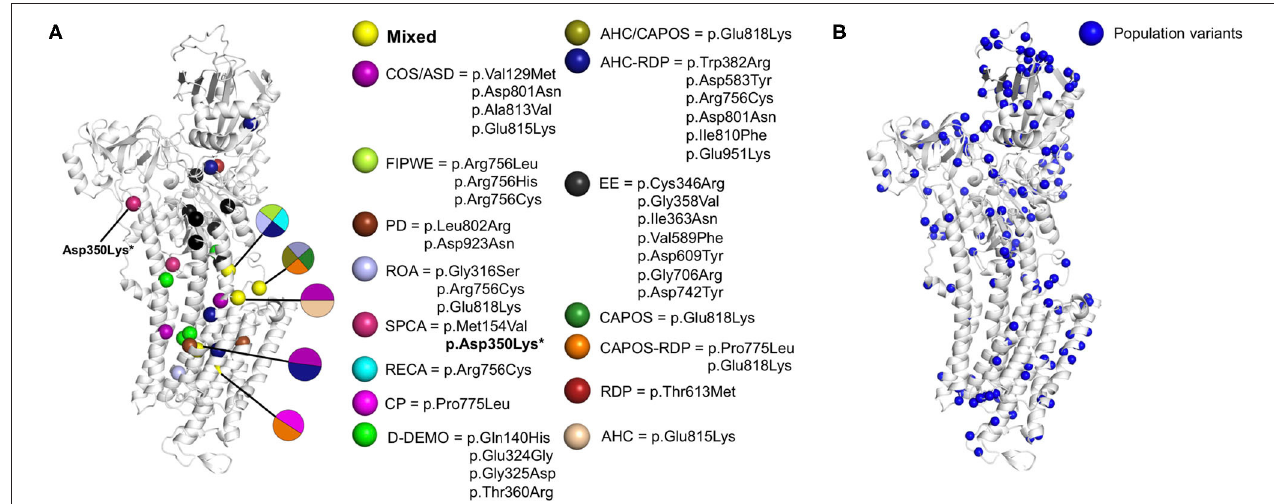
FIGURE 2 | ATP1A3 missense variants mapped on a protein structure model of the α 3 subunit of the Na + /K + -ATPase. The homology model was obtained from the SWISS-Model repository (template: 4RET). (A) Pathogenic missense variants. Spheres are colored by disorder type. Residues associated with multiple distinct disorders were colored in yellow. (B) Population variants in ATP1A3 were collected from the gnomAD database (81) and visualized as blue spheres on the homology model. *Asp350Lys did not match any protein isoform in Uniprot (82), could not be aligned to the canonical ATP1A3 sequence and is thus not displayed in the figure. In case of AHC and RDP, we only included the pathogenic variants reported as more frequent according to the references (8, 14), respectively. AHC, alternating hemiplegia of childhood; ASD, autistic spectrum disorder; CAPOS, cerebellar ataxia, areflexia, pes cavus, optic atrophy, and sensorineural hearing loss; COS, childhood-onset schizophrenia; CP, cerebral palsy; D-DEMO dystonia, dysmorphism, encephalopathy, MRI abnormalities, and no hemiplegia; EE, early life epilepsy; FIPWE, fever-induced paroxysmal weakness and encephalopathy; PD, paroxysmal dyskinesias; RECA, relapsing encephalopathy with cerebellar ataxia; RDP, rapid-onset dystonia-parkinsonism; ROA, rapid onset cerebellar ataxia; SPCA, slowly progressive cerebellar ataxia.